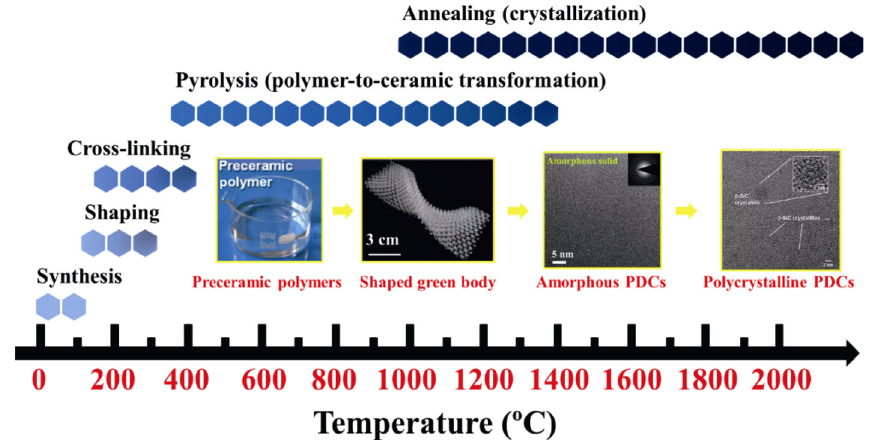
Fig. 1 General processes involved in the producing of polymer-derived ceramics. Reproduced with permission from Ref. [36], © Elsevier Ltd. 2019; Ref. [39], © Acta Materialia Inc. 2017; Ref. [40], © Elsevier Ltd.